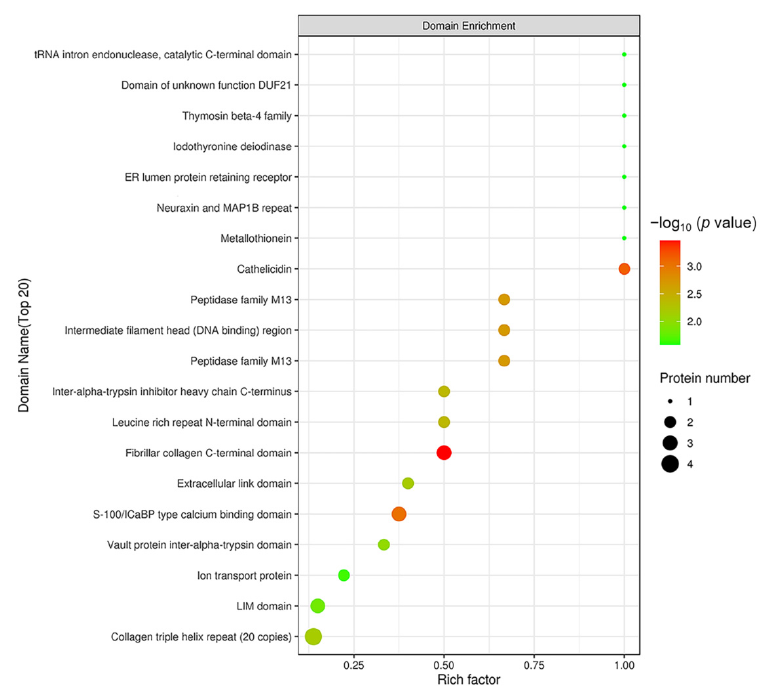
Figure 8. Structural domain enrichment analysis. The abscissa is the enrichment factor (Rich factor ≤ 1). The ordinate represents the statistical results of DEPs under each domain classification. The bubble color represents the significance of the enrichment of structural domain classification, namely, the p value was calculated using Fisher’s Exact Test and the color gradient represents − log 10 ( p value). The closer the color is to red, the smaller the p value and the higher the level of significance of the enrichment under the corresponding structural domain classification.